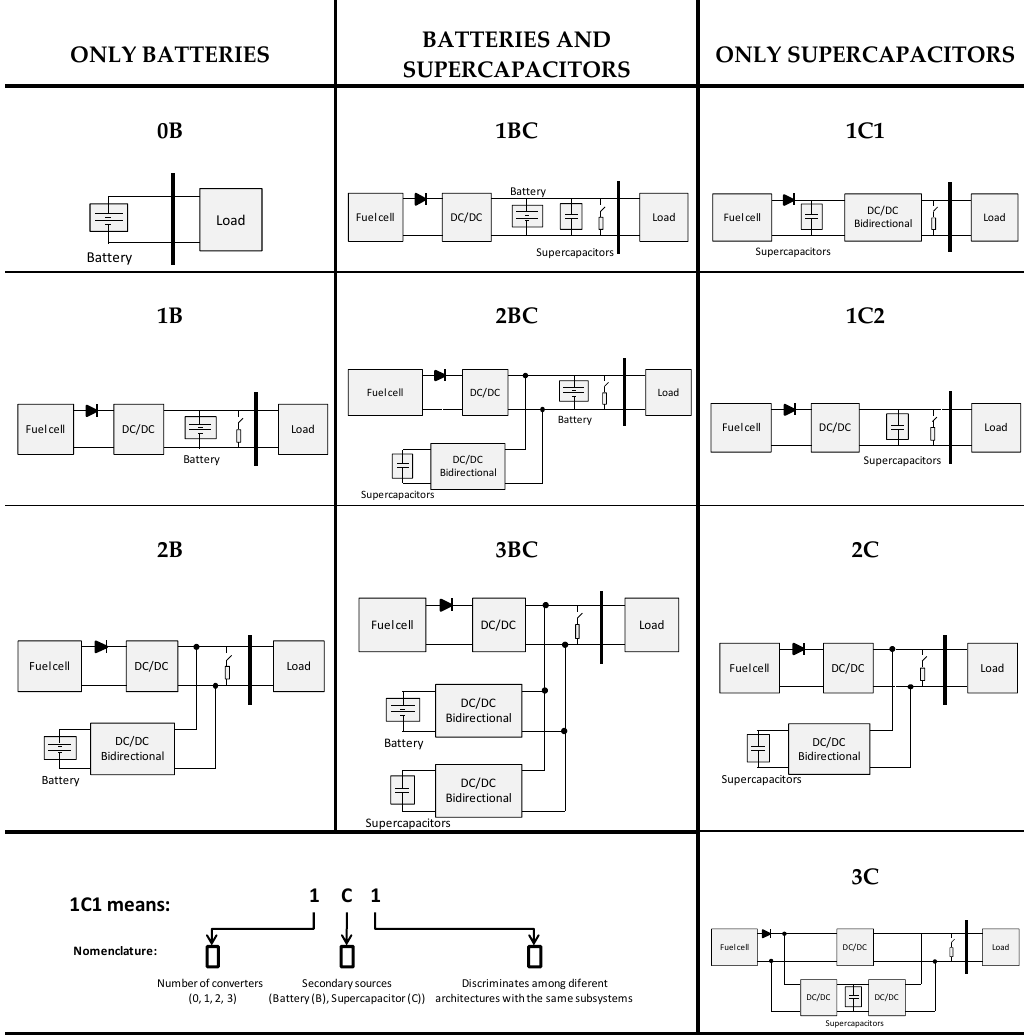
Figure 1. Power distribution architectures based on the fuel cell, supercapacitors, and battery [23].